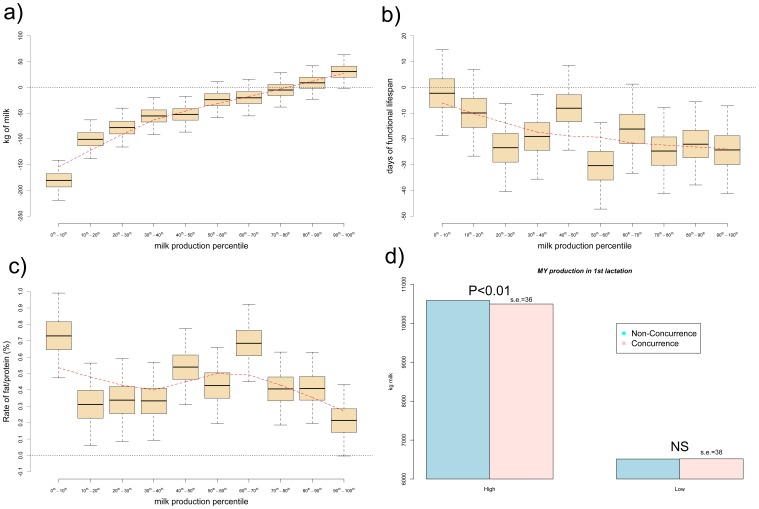
Effect of maternal production level during embryogenesis on adult performance.The boxplots show the effect of the maternal milk yield level (by percentiles) during embryogenesis in the performance of the adult individual for a) milk yield, b) lifespan and c) fat/protein. Values are expressed in relation to individuals whose embryogenesis occurred in the absence of maternal lactation. Boxes contain the lower and upper 25th –percentiles of the posterior distribution and whiskers contain the respective highest probability density interval at 99%. The red-dashed line is the non-parametric regression of the performance of the individual on maternal milk yield level from the loess function in R [33]. d) The concurrence of maternal lactation during embryogenesis reduced the milk yield performance by 90 kg (P-value<0.01) in the adult life of females above the 90th percentile of additive genetic value, whereas it did not have effect on individuals with low genetic merit (in the lower 10th percentile).